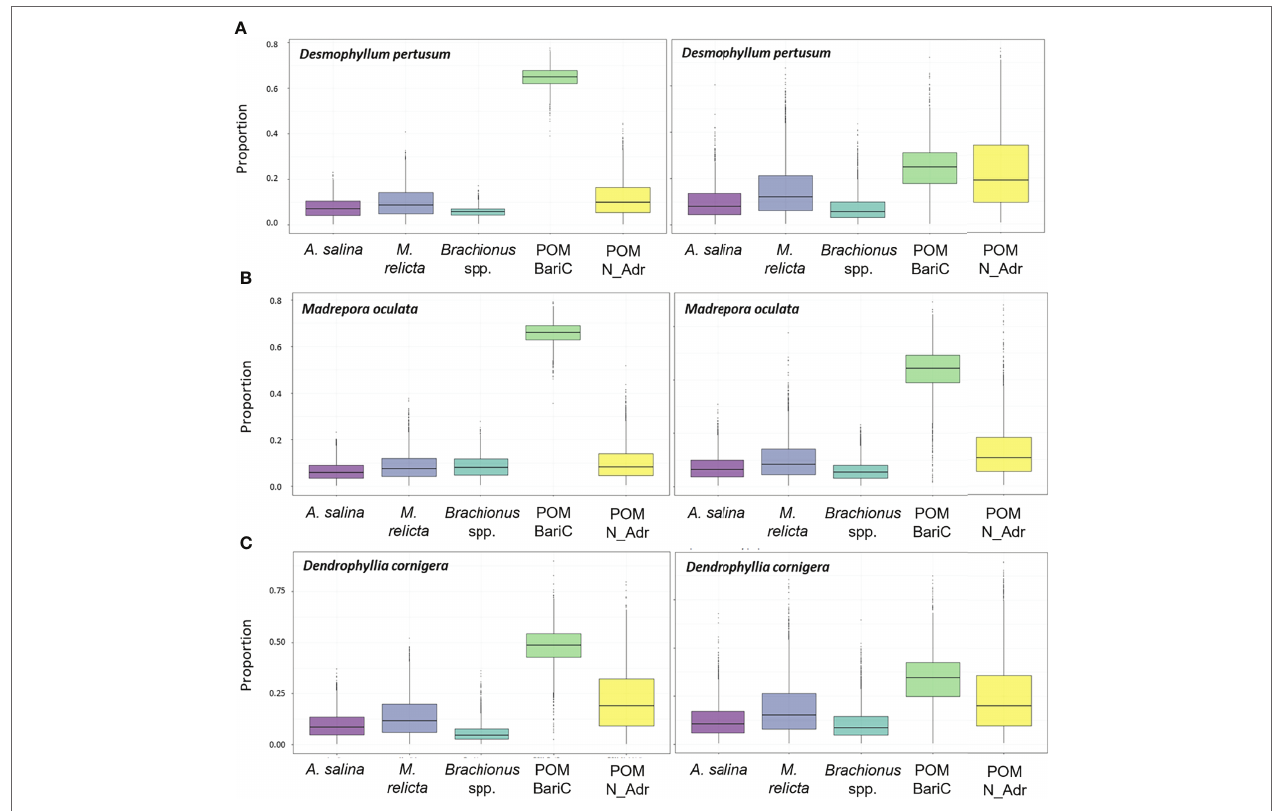
FIGURE 3 | Posterior probabilities for the proportional contribution of each food source to the diet of (A) D . pertusum , (B) M. oculata and (C) D . cornigera obtained with stable isotope analysis mixing models. Each plot shows proportions for each food source at the beginning (figures on the left, T 0 ) and at the end (figures on the right, T f ) of the experiment. The horizontal line within the box represents the median, the boundaries of the boxes represent the first and second quartiles and the whiskers of the boxes represent the 95% credibility interval. POM BariC = Particulate Organic Matter of Bari’s canyon; POM N _ Adr = Particulate Organic Matter of the North Adriatic